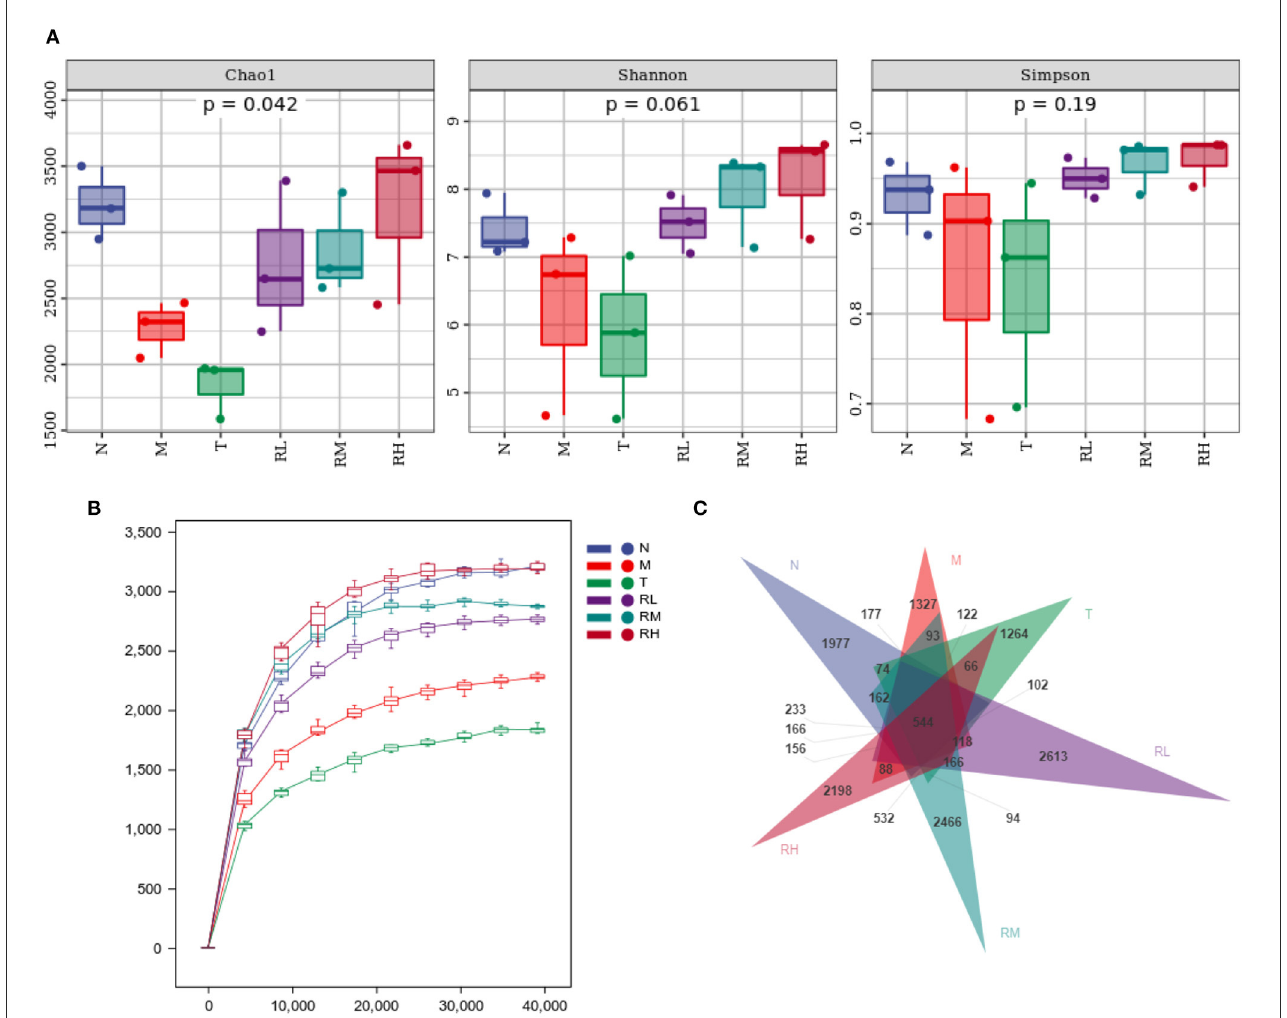
FIGURE7 Effect of RGO on intestinal flora diversity in mice. (A) Alpha diversity index. (B) Dilution curve. (C) OTUs exclusivity